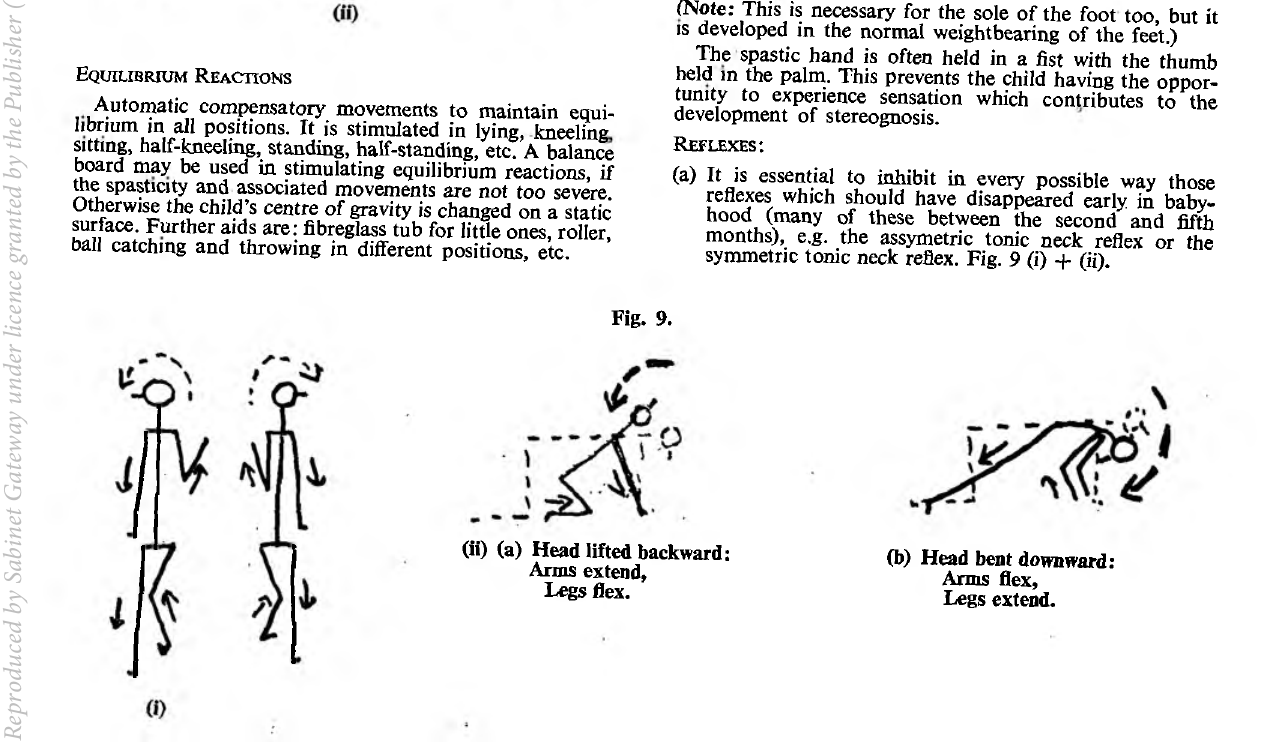
(i) Sit on table, change centre of gravity (Notice that the eyes stay in a horizontal line. (ii) Kneeling, change centre of gravity — eye level stavs horizontal. (iii) Pushed backward in standing (also sitting or kneeling) — eye level stays horizontal.